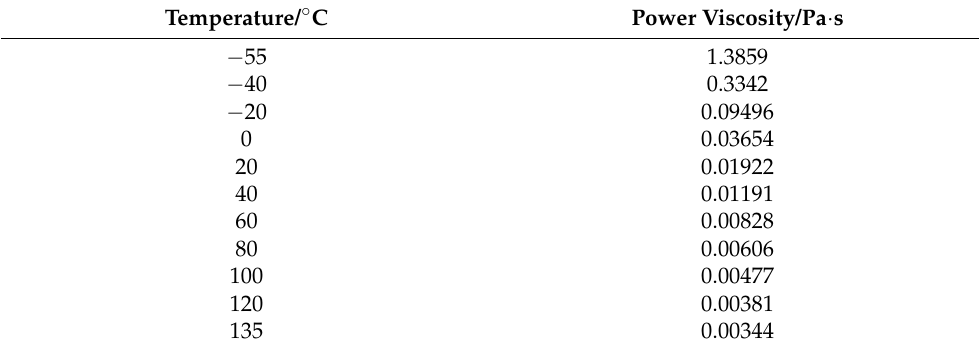
Table 2. Chinese YH-15 aviation hydraulic oil dynamic viscosity values at different